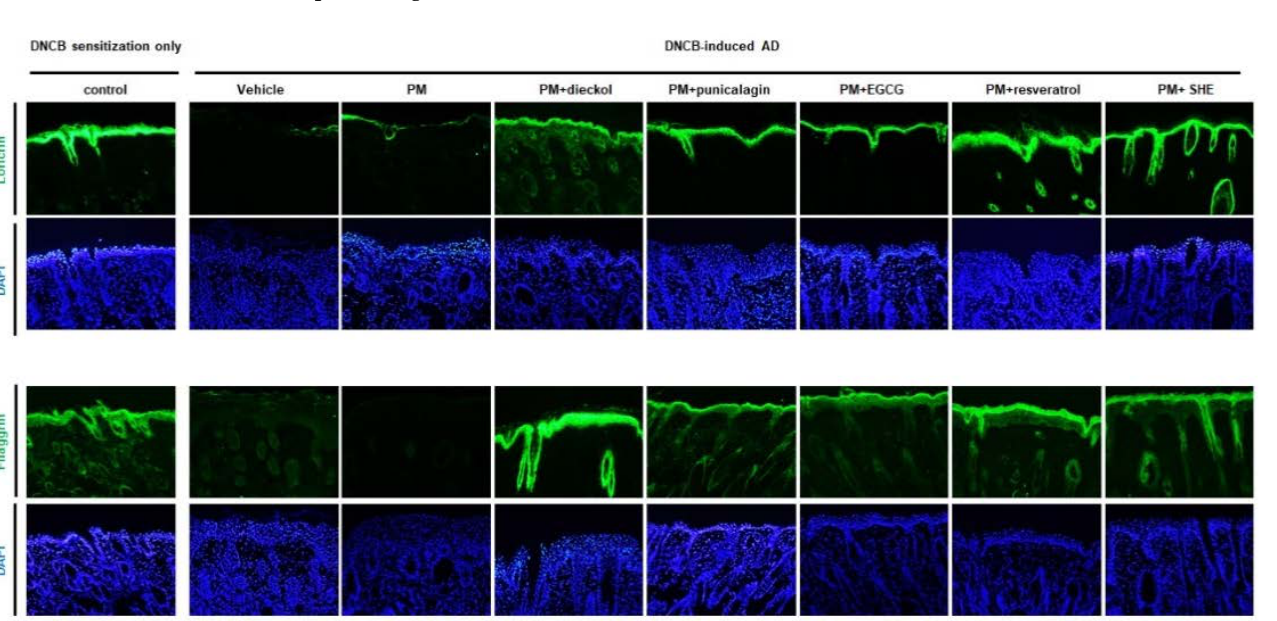
Figure 6. Preventative effects of antioxidants on the upregulation of the keratinocyte differentiation markers in the particulate matter <10 μm (PM 10 )-treated, 2,4-dinitrochlorobenzene (DNCB)-induced atopic dermatitis mice. The downregulation of keratinocyte differentiation markers by PM 10 alone was prevented by the combination of dieckol, punicalagin, epigallocatechin-3-gallate (EGCG), resveratrol, or Siegesbeckiae Herba extract (SHE) (* p < 0.05).